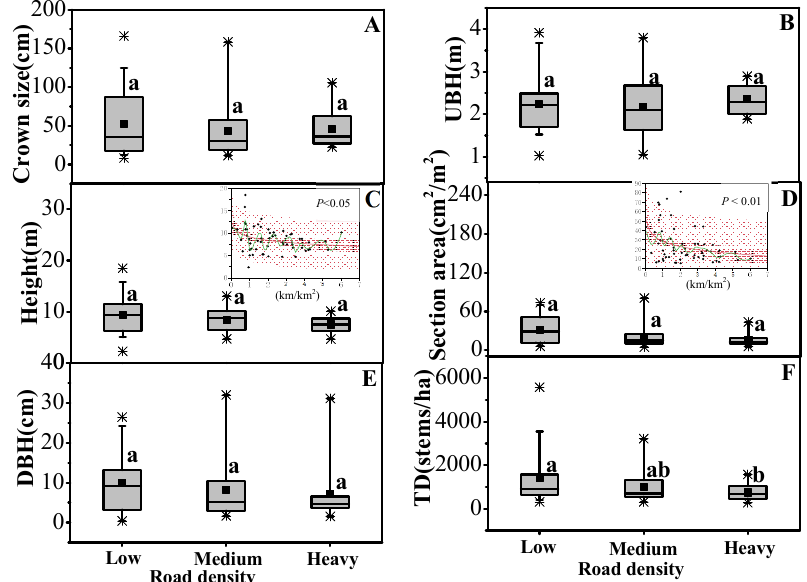
Figure 5. Structural attributes at different road densities (RD). ( A ) crown size, ( B ) under branch height (UBH), ( C ) height, ( D ) section area at breast height (DBH section area), ( E ) diameter at breast height (DBH), and ( F ) tree density (TD). The boxplots show the mean (black square), median (black line in the box), inter-quartile range (25%–75% in the box), and the range of normal values (the whisker). The mean values sharing different letters are significantly different ( p < 0.05), and the different letters in different RD regions are significantly different in their arithmetic means ( p < 0.05). The figure insets depict significant regression lines from the raw data. The red line is the regression line, and the green lines represent the moving mean value. The dual-shaded shadows represent the best-fitting and predicted interval ranges.